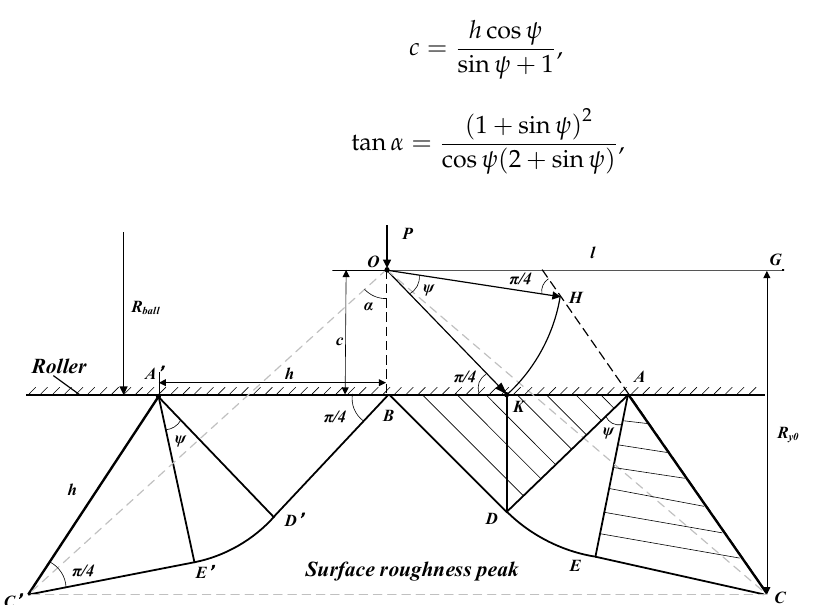
Figure 5. Plastic deformation of surface roughness peak in SS.